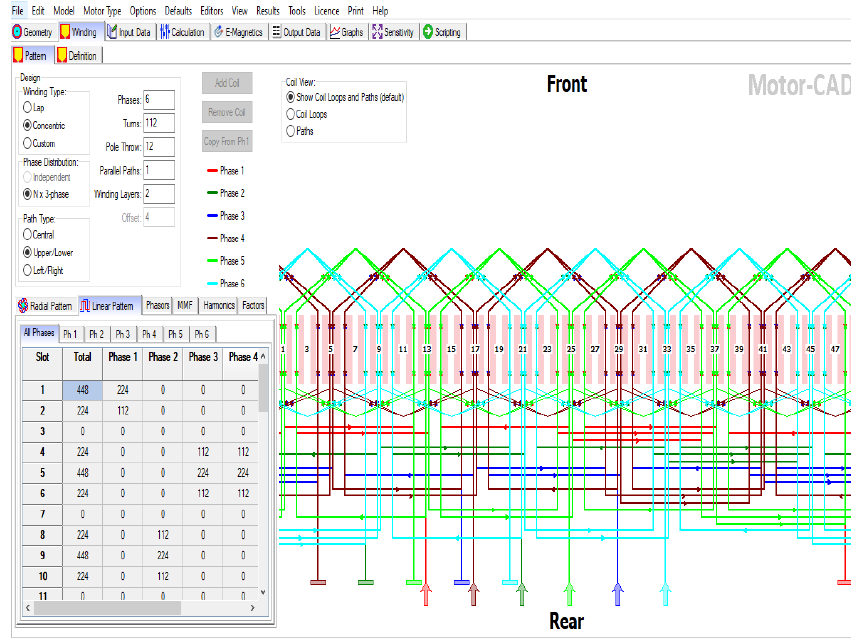
Figure 7. Linear Pattern of the Six Phase Induction Motor